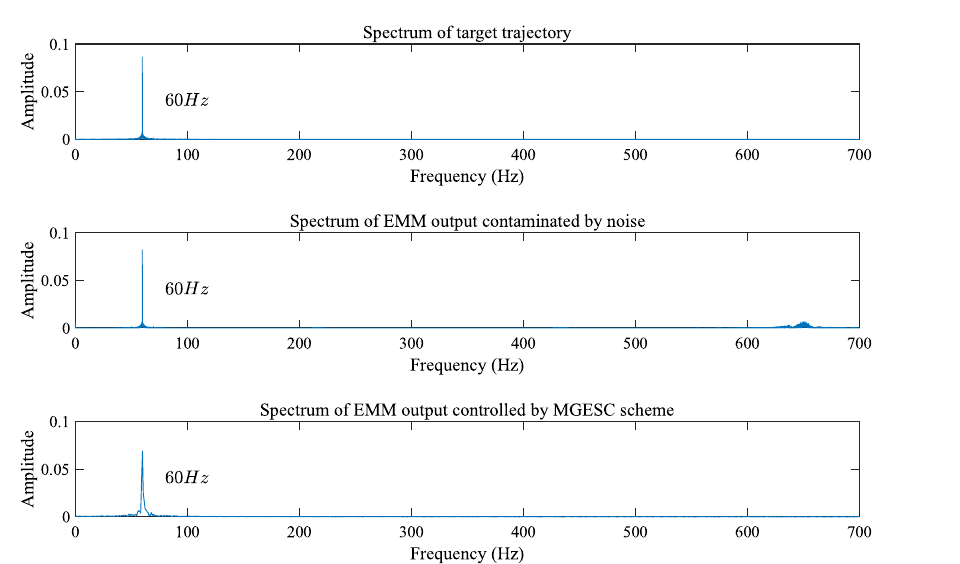
Figure 10. Spectrum analysis of the noise suppression using MGESC